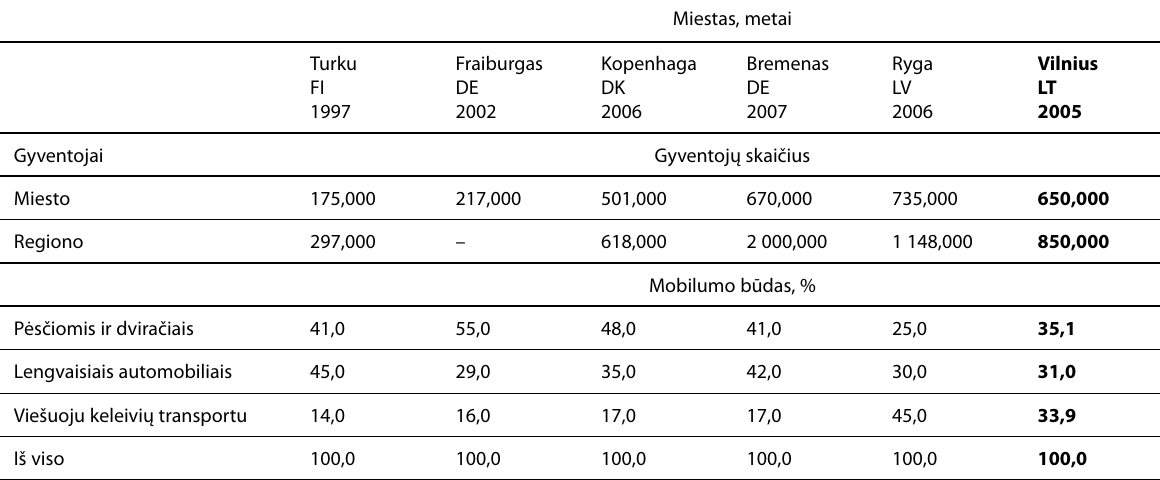
2 lentelė. Susisiekimo būdų pasiskirstymo palyginimas europos miestuose (Vilniaus miesto savivaldybės ... 2006; rygos ... Table 2. comparison of modal split of mobility in european cities (Vilniaus miesto savivaldybės ... 2006; rygos ... 2006; baltic Urban ... 2005–2007; Danijos dviratininkų asociacijos tinklapis; Dviračių susisiekimo plėtra bremeno